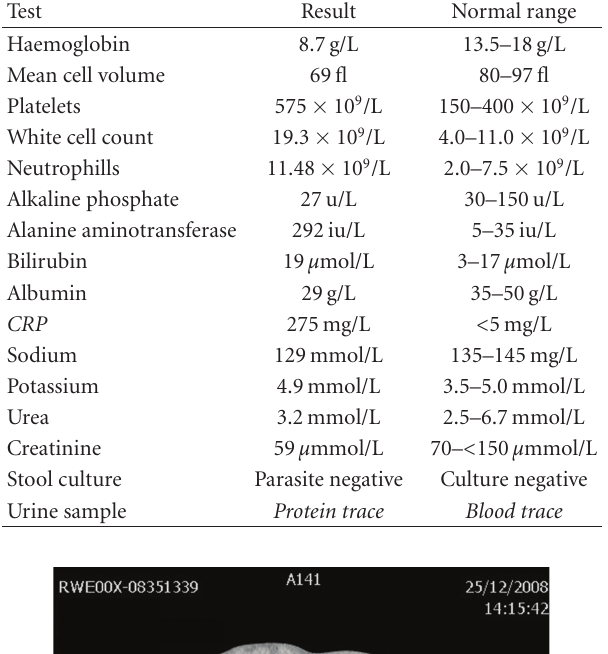
Table 1: Laboratory results including urine + stools samples.